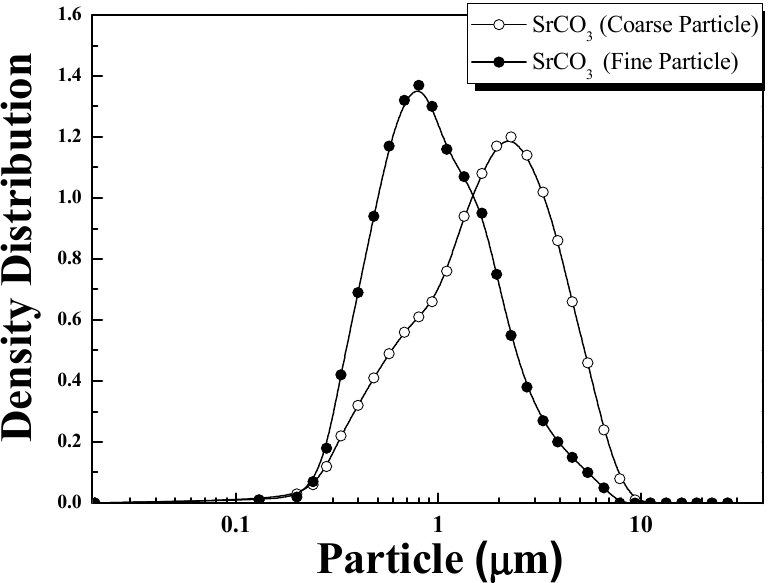
Figure 3. Particle size distribution of two different raw material SrCO 3 measured by the Sympatec laser scattering system.